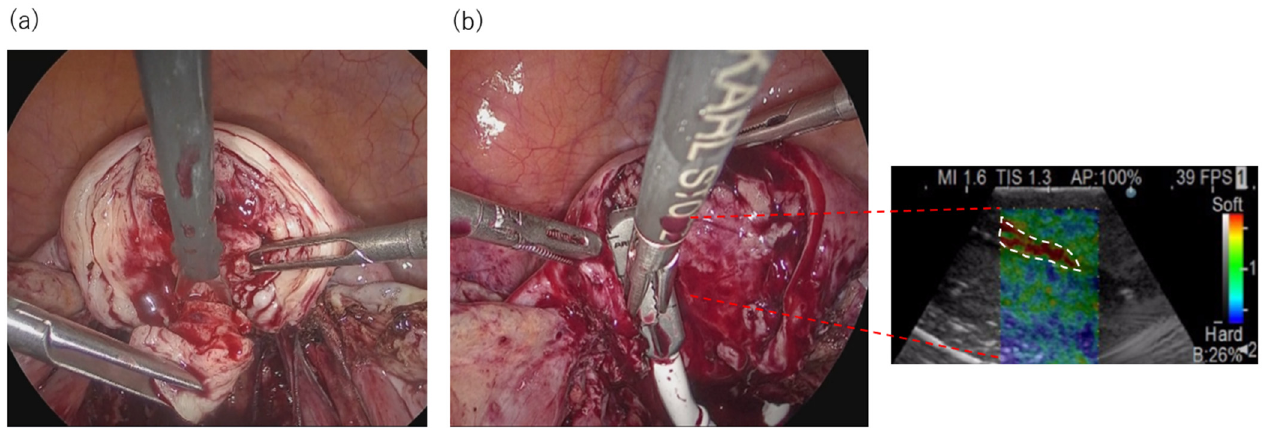
Figure 4. ( a ) Real-time elastography confirmed residual lesions, which were excised using scissor forceps. ( b ) The left side of the posterior wall of the uterus is shown in green, confirming that no residual lesions are noted. The red area indicates the endometrium.